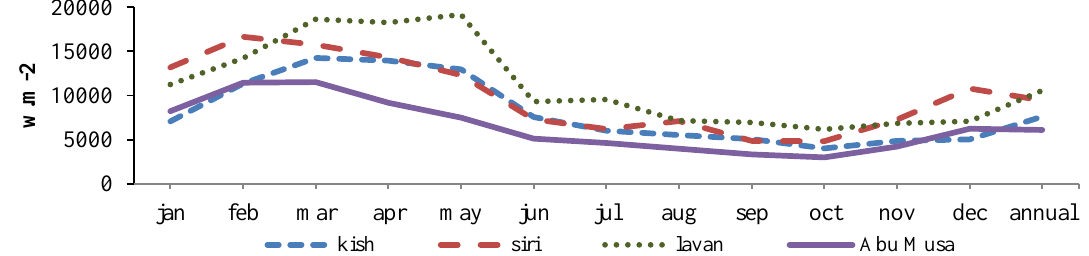
Figure 9. Wind power in islands with 15 m radius rotor